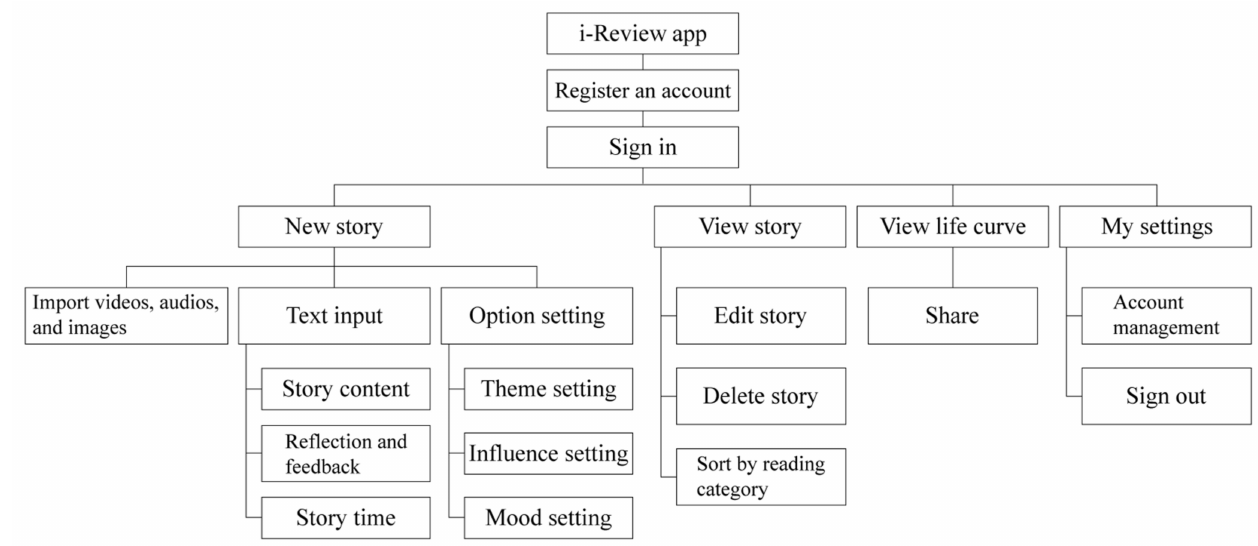
Figure 1. Functional structure of the i-Review interactive app.